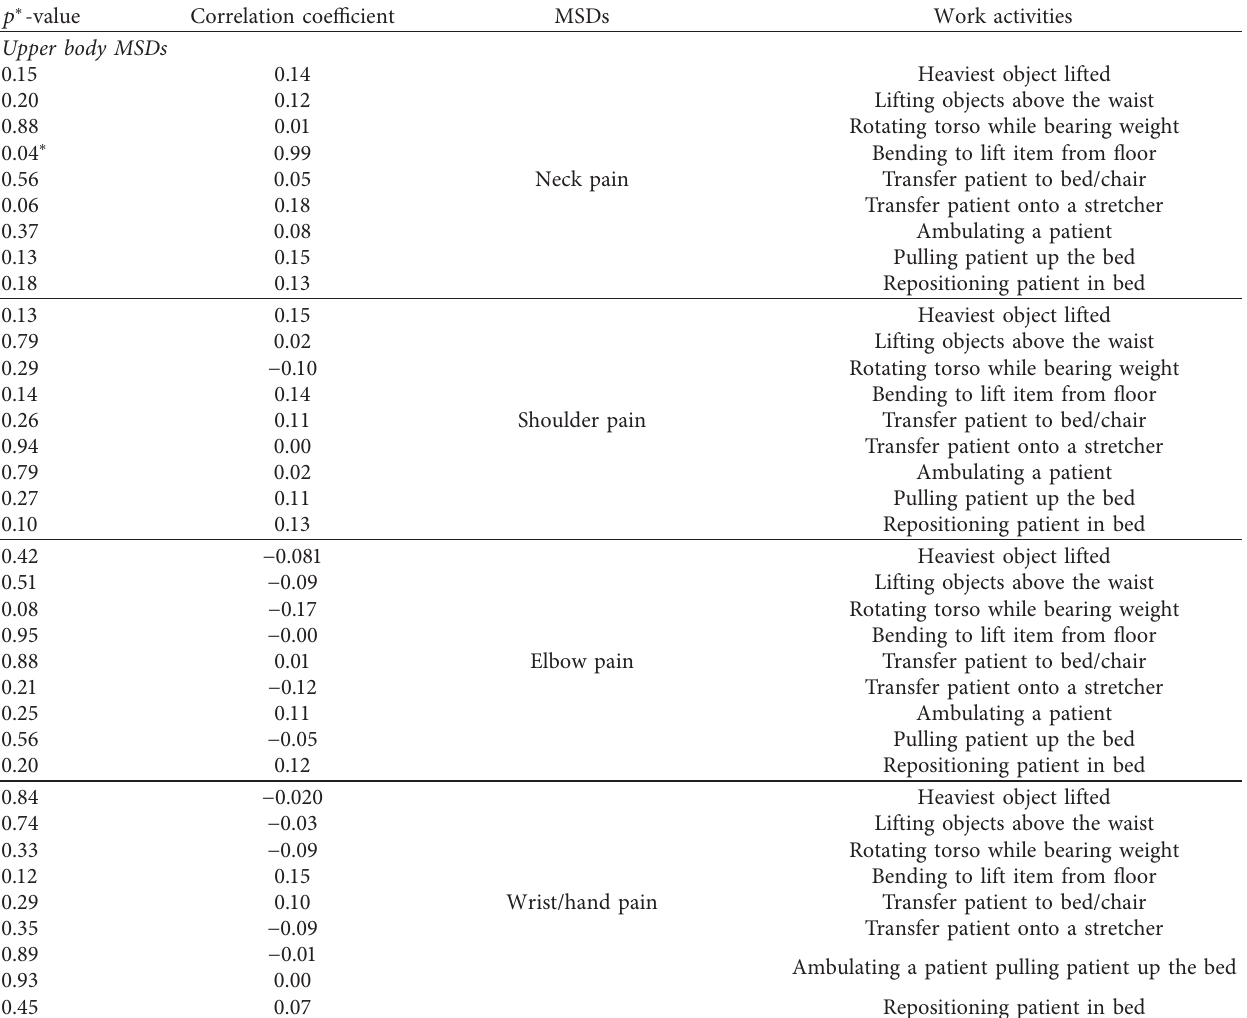
Table 6: Association of work activities related to upper and lower body MSDs among studied critical care nurses. p ∗